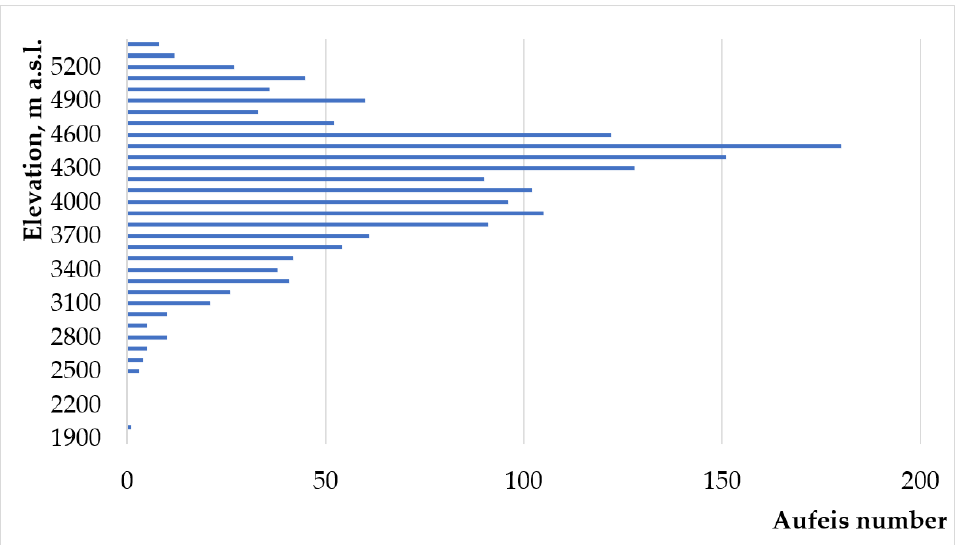
Figure 4. Plot of the Aufeis distribution with elevation in the Kunlun Mountains on the northern edge of the Qinghai-Tibet Plateau, West China.